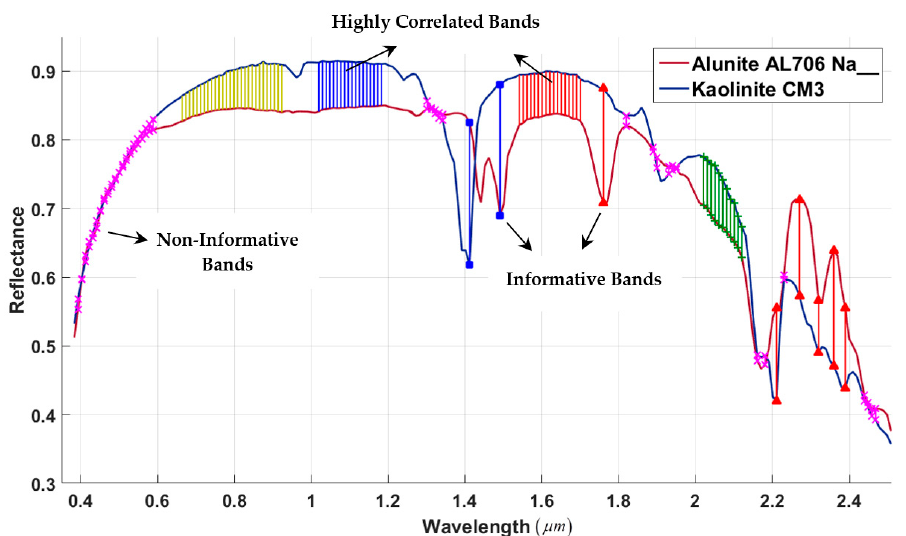
Figure 2. The spectrum of alunite and kaolinite minerals and the highly-correlated regions among the adjacent bands.